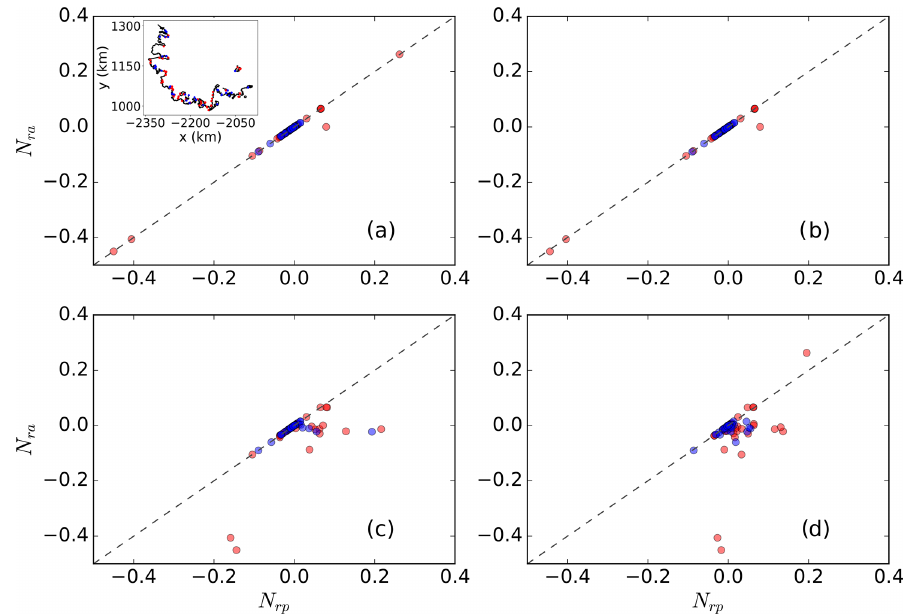
Figure 13. Comparisons between perturbation- and adjoint-based sensitivities ( N rp and N ra , respectively) for ice thickness perturbations of (a) 0.001, (b) 0.01, (c) 1, and (d) 10m for perturbation points near the grounding line ( < 3km), indicated by the dots on the inset map in (a) . Red dots represent grid cells next to the grounding line, and blue dots represent grid cells on the ice shelf